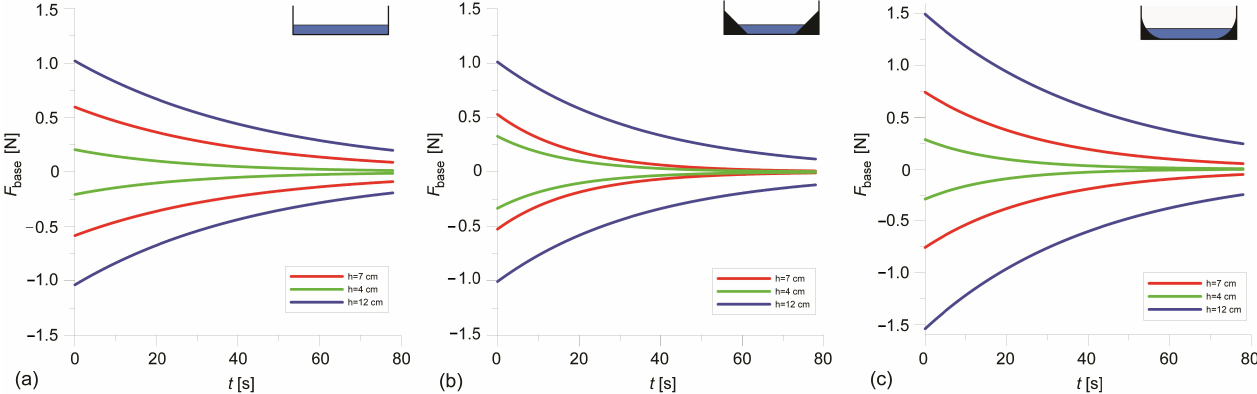
Figure 8. Exponential decay functions interpolated at different water depths for flat ( a ), sloped ( b ) and circular ( c ) bot- tom shape.